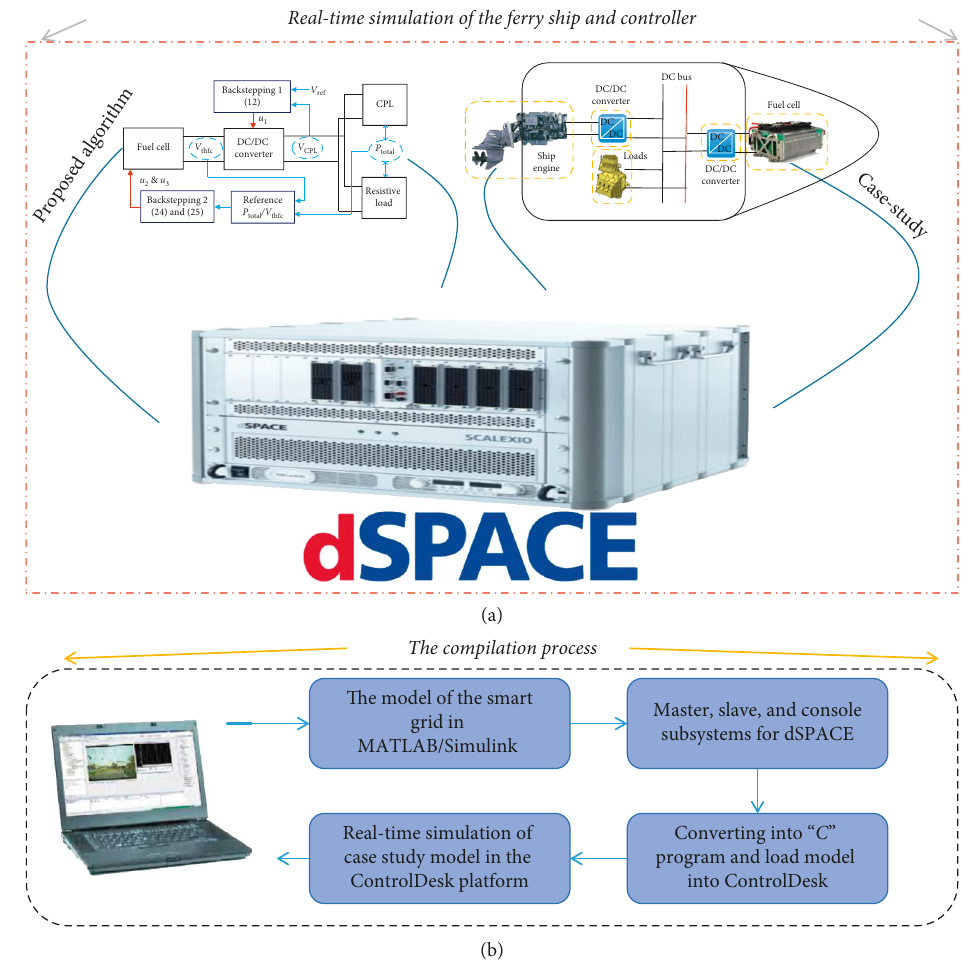
Figure 4: MiL real-time setup and configuration of the marine DC MG